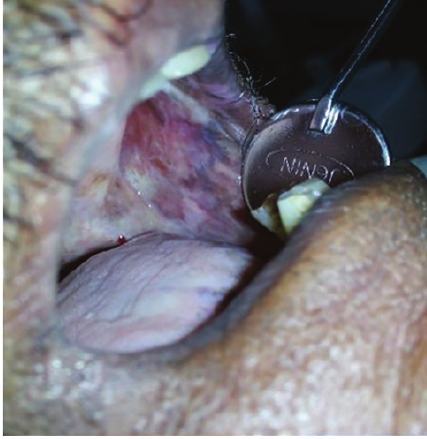
Figure 2: Blanching of the oral mucosa.